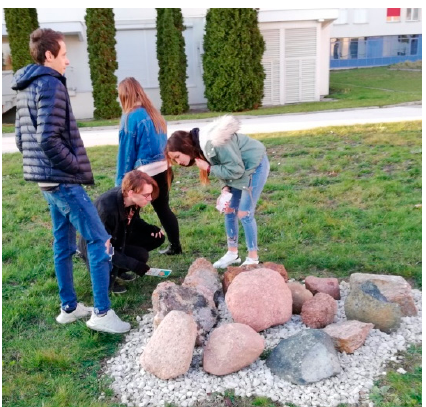
Figure 14. During Geomorphology Week, an event organized periodically under the auspices of the Association of Polish Geomorphologists, the Workshop participants learned to recognize the basic petrographic types of rocks.